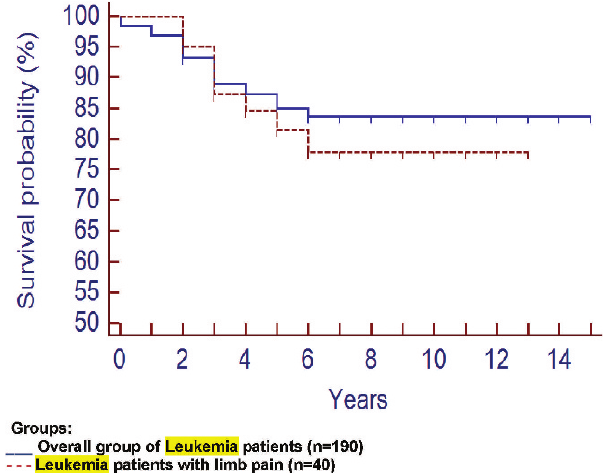
Figure 2 - The Kaplan-Meier overall survival curves between the whole group of leukemia patients (n=190) and leukemia patients with limb pain (n=40) ( p =0.4875).